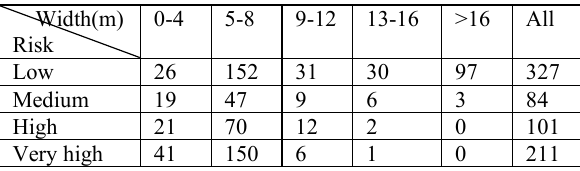
Table 7 . Road closure risk statistics. Source: de Vries, 2022